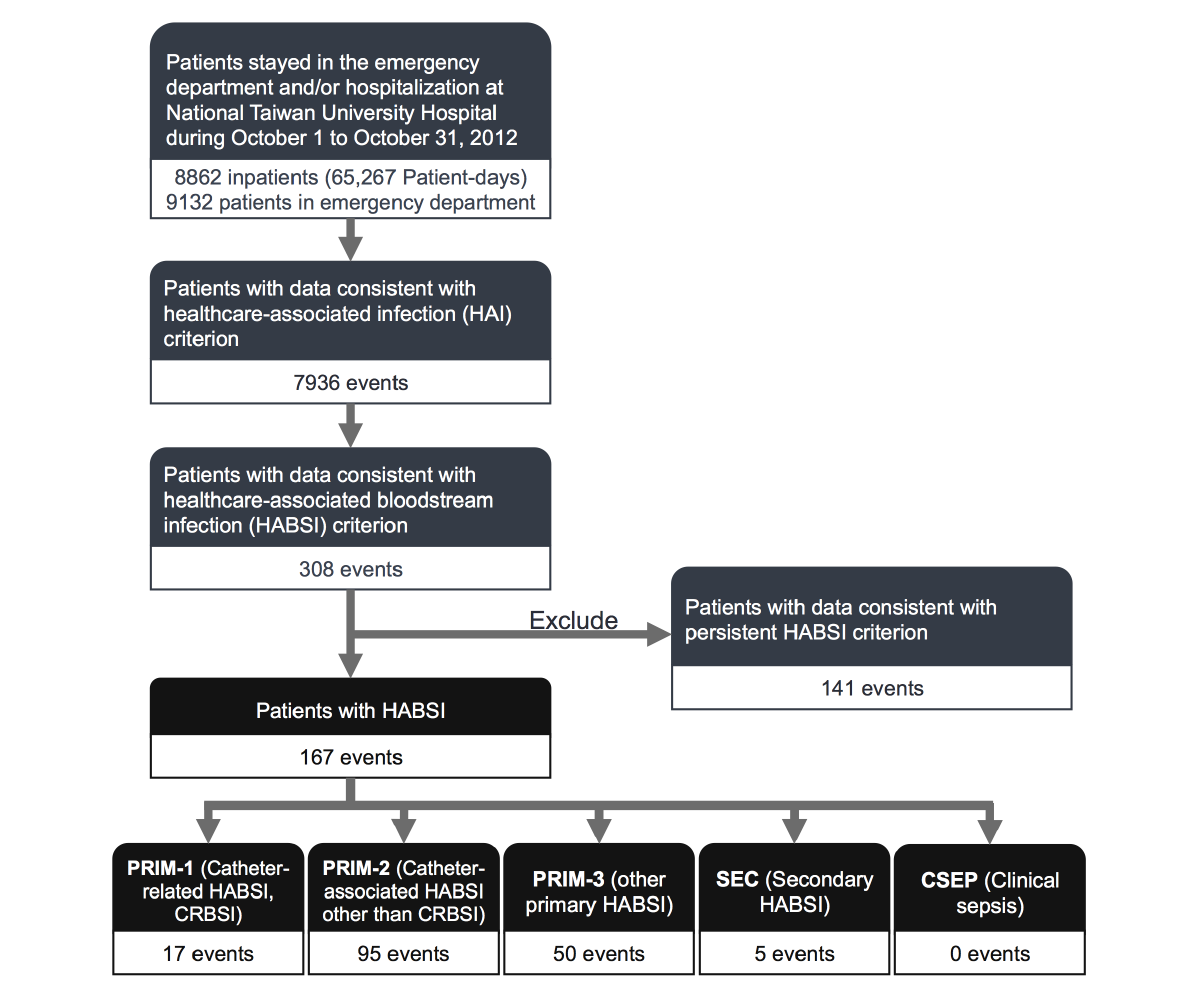
Figure 5. Computer algorithms identifying 167 events of health care-associated bloodstream infection among 8862 inpatients and 9132 patients in the emergency department between October 1 and October 31, 2012 (31